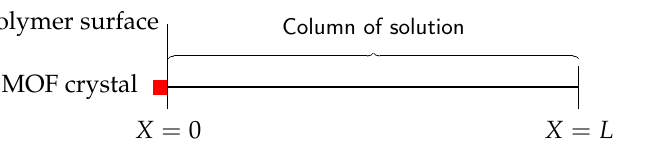
Figure 3. One-dimensional representation of ferric ions diffusing through a column of solution with MOF crystal at the left